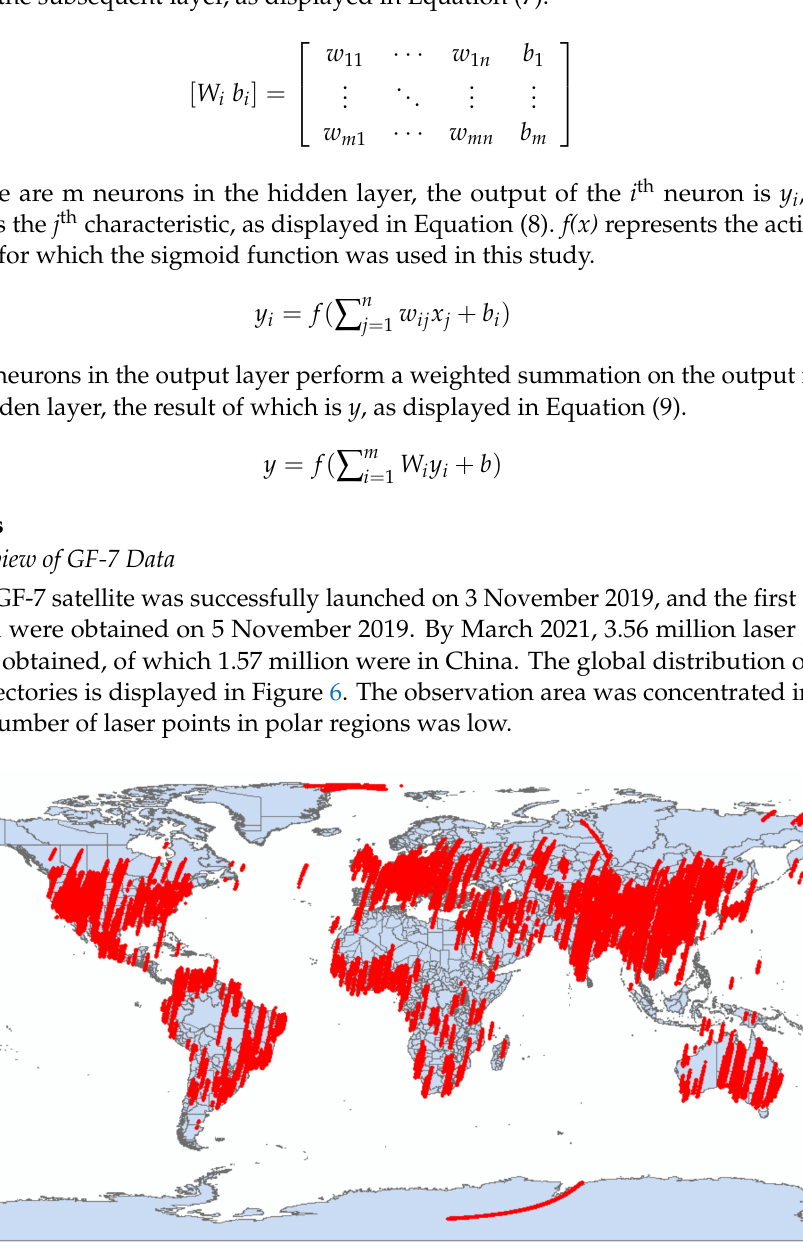
Figure 6. Distribution of laser data obtained from the GF-7